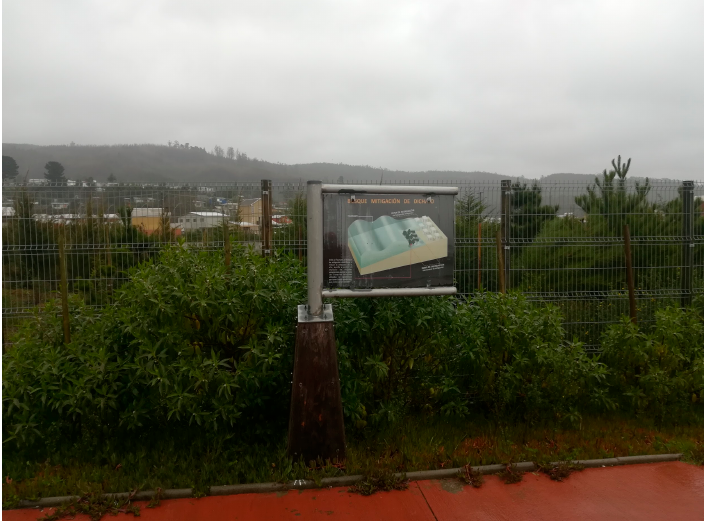
Figure 11. Layer 2 measures in Dichato, tsunami protection forest.